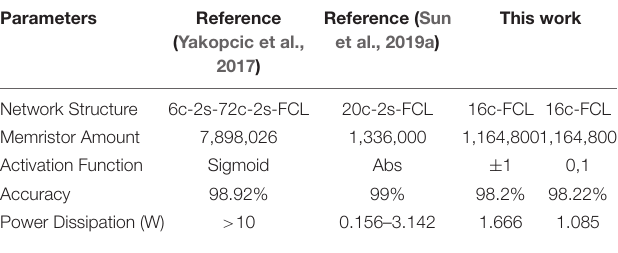
TABLE 3 | Performance comparison with other